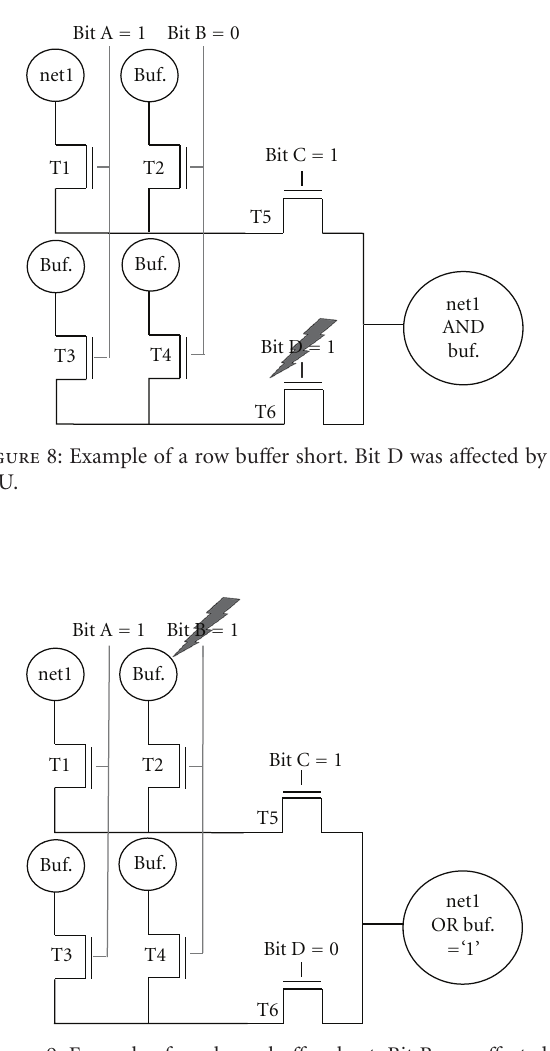
Figure 9: Example of a column bu ff er short. Bit B was a ff ected by an